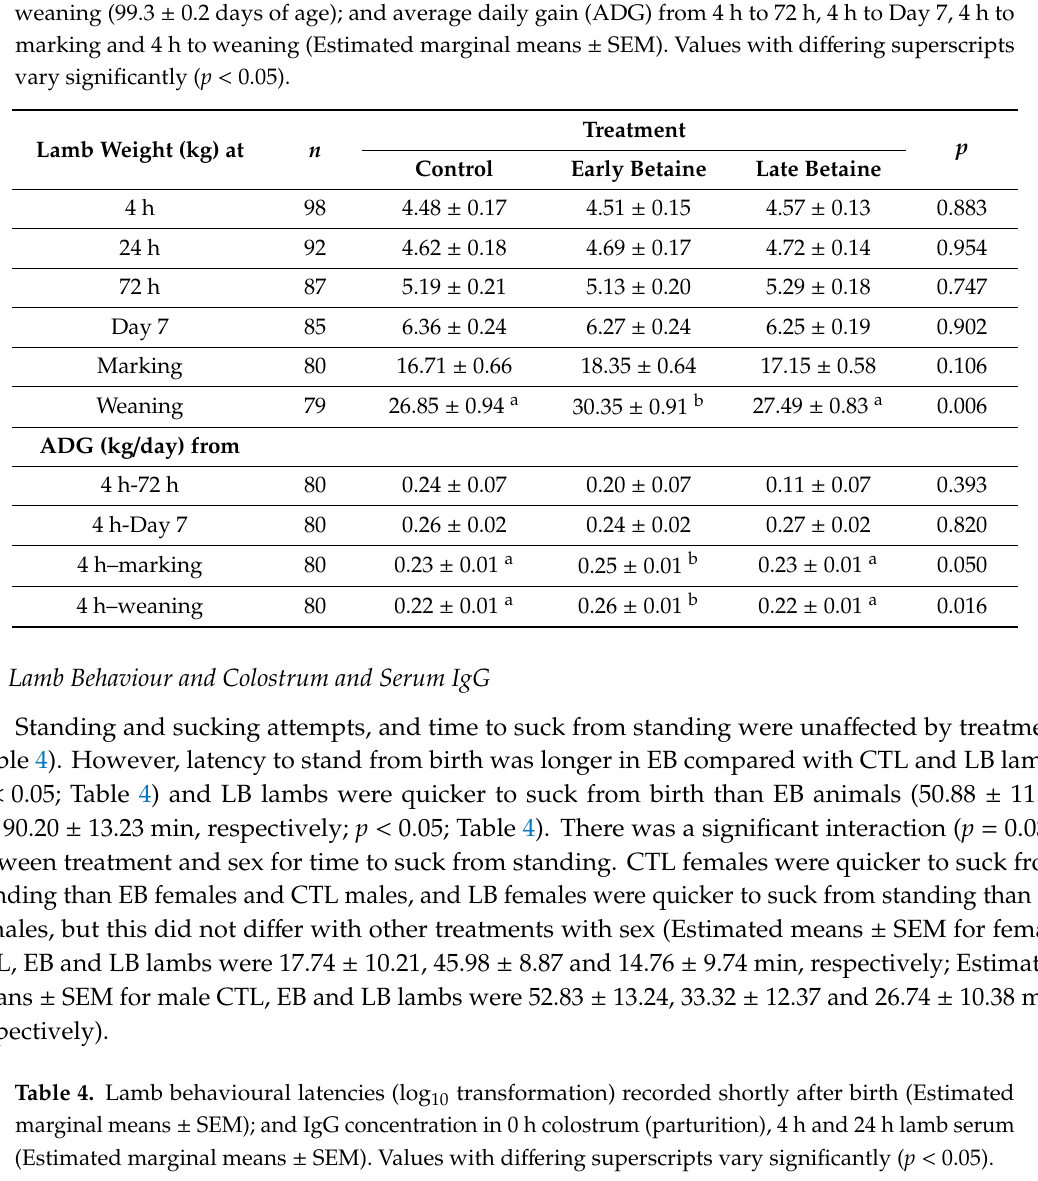
Table 4. Lamb behavioural latencies (log 10 transformation) recorded shortly after birth (Estimated marginal means ± SEM); and IgG concentration in 0 h colostrum (parturition), 4 h and 24 h lamb serum (Estimated marginal means ± SEM). Values with di ff ering superscripts vary significantly ( p < 0.05). Treatment Behavioural Latencies n